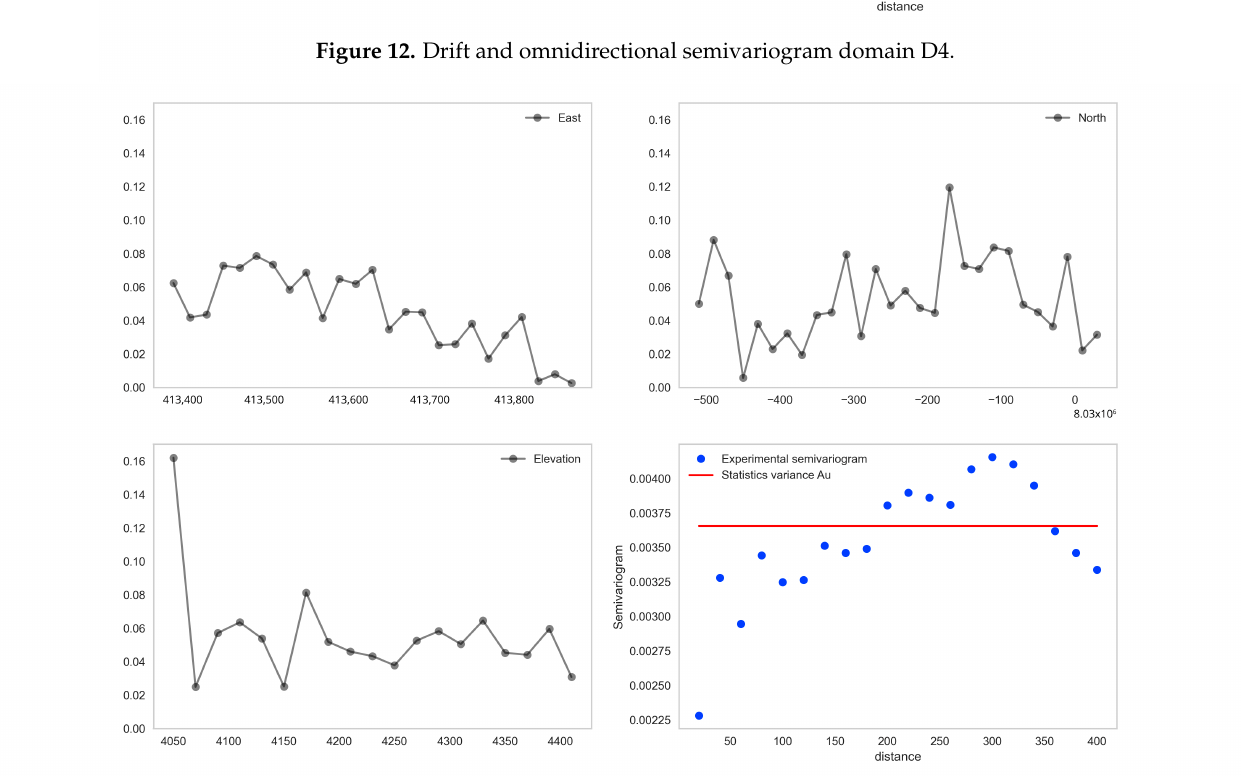
Figure 13. Drift and omnidirectional semivariogram domain